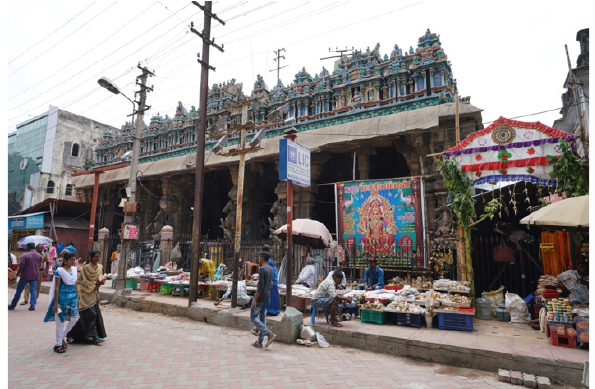
Figure. 4 Plan derived from (Branfoot